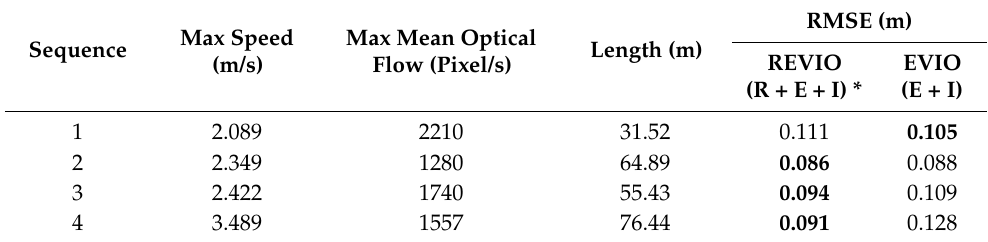
Table 2. The root mean squared error (RMSE) of the proposed approach using range (R), events (E) and IMU (I) against using event and IMU. RMSE (m) Max Speed Max Mean Optical Sequence Length (m) REVIO (m/s) Flow (Pixel/s) (R + E + I) * (E +